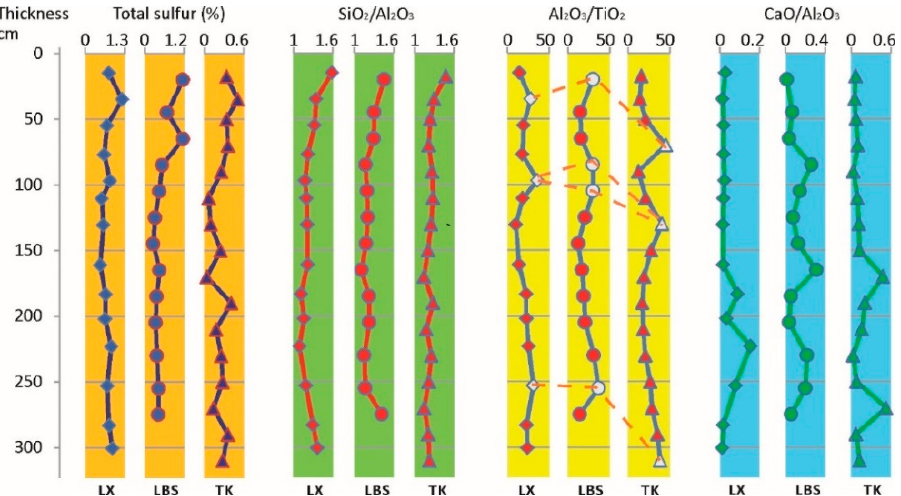
Figure 2. Variations of total sulfur content, the SiO 2 /Al 2 O 3 ratio, the Al 2 O 3 /TiO 2 ratio, and the CaO/Al 2 O 3 ratio in the profiles of the three Upper No. 3 coals from Luxi (LX), Liangbaosi (LBS), and Tangkou (TK) mines.